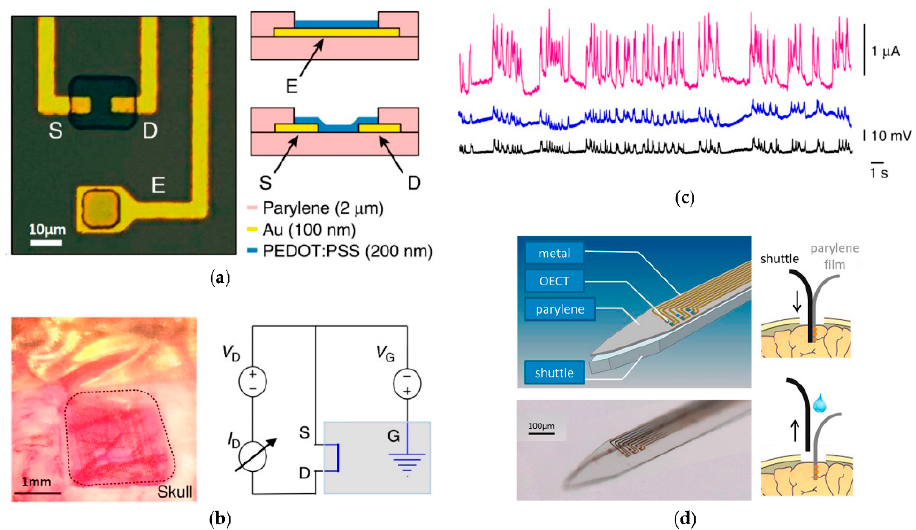
Figure 11. ( a ) Optical micrograph (left) and schematic layout (right) of the channel of OECT and surface electrode (left), in which the Au films that act as source (S), drain (D) and electrode pad (E) are identified; ( b ) Optical micrograph of the ECoG probe placed over the somatosensory cortex (left) with the craniotomy surrounded by dashed lines; and wiring layout of the transistor (right) with the blue box indicating the brain of the animal; ( c ) Recordings from an OECT (pink), a PEDOT:PSS surface electrode (blue) and an Ir-penetrating electrode (black). The transistor was biased with V DS = − 0.4 V and V GS = − 0.3 V and the scale of 10 mV is for both surface and penetrating electrodes; ( d ) Layout of the entire probe showing the parylene and the shuttle parts (top), corresponding optical micrograph (bottom) and principle of delamination (right). ( a – c ) Reprinted by permission from Macmillan